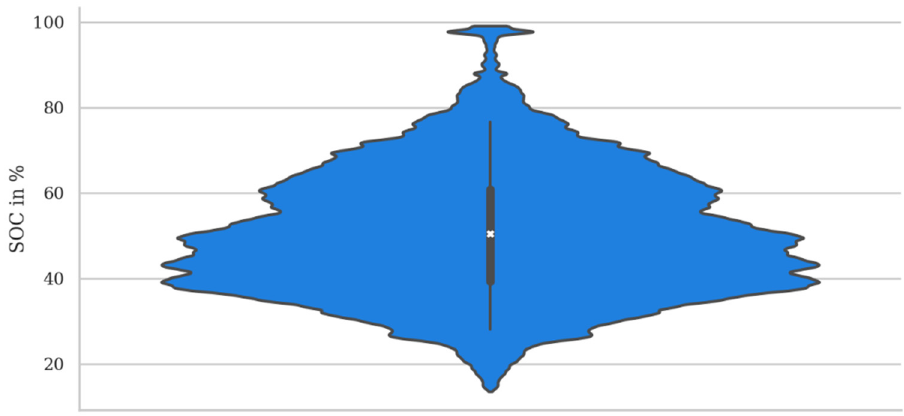
Figure 6. Distribution of the SOC of the LSS.